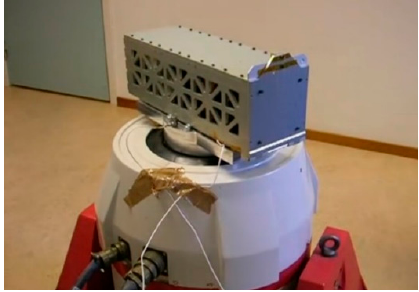
Figure 10. SE01 in a 3U fixture on the electric shaker facility.